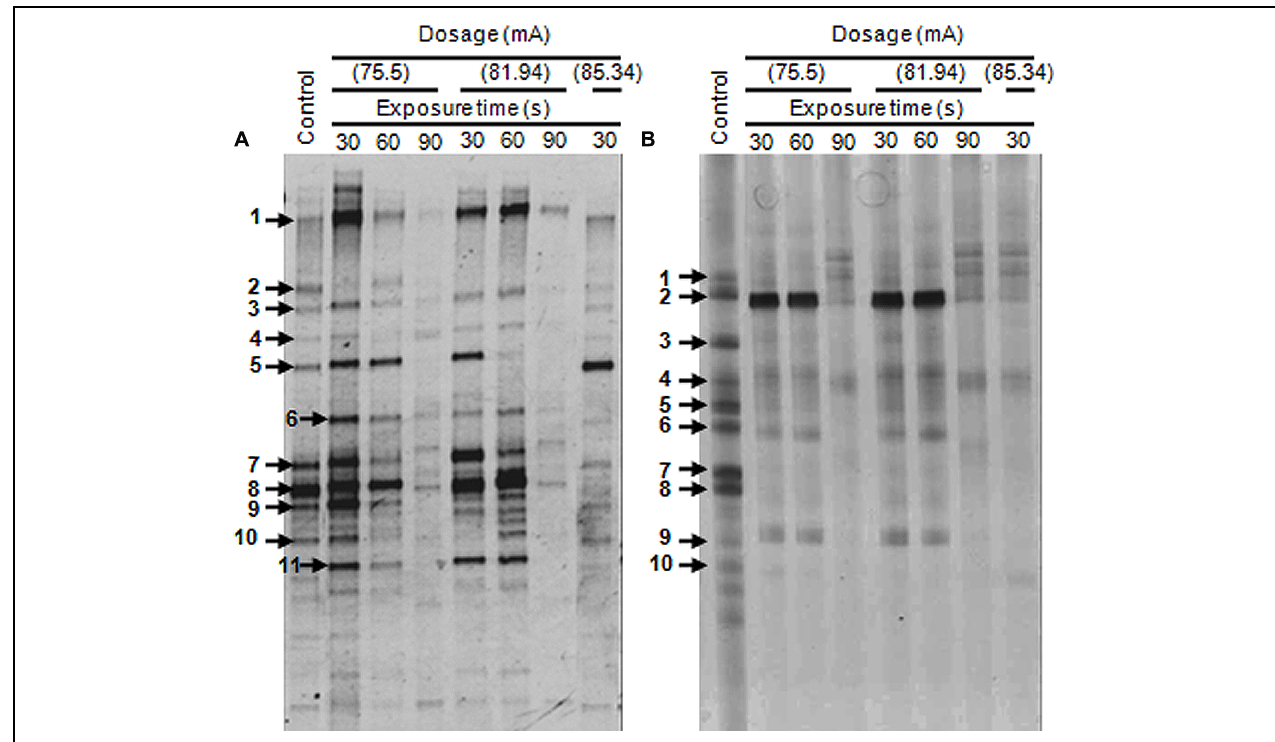
FIGURE 5 | Denaturing gradient gel electrophoresis (DGGE) profiles of 16S rDNA amplified from genomic DNA for untreated and plasma-treated wastewater samples. (A) Samples from the food processing industry. (B) Samples from the leather industry. Faint DGGE bands representing polymerase chain reaction (PCR) artifacts were neglected.